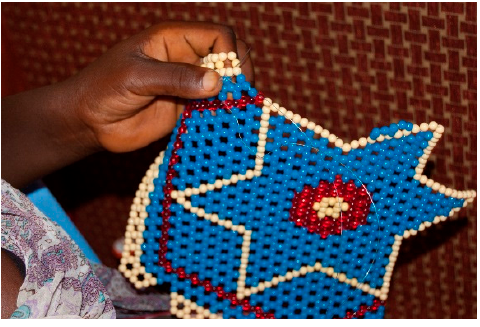
Figure 7. Threading beads.